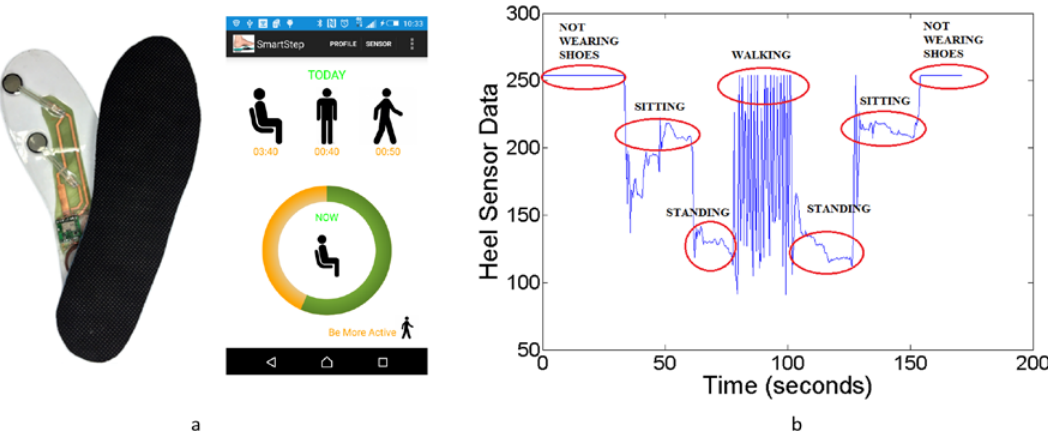
Figure 3. ( a ) SmartStep system by Hegde et al. [80]; and ( b ) heel pressure sensor signals for daily living activities [76].